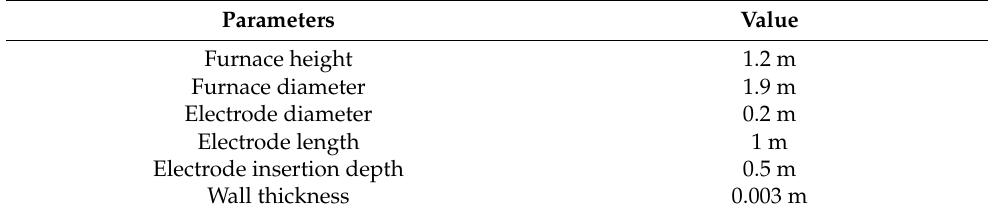
Table 1. Furnace parameters.